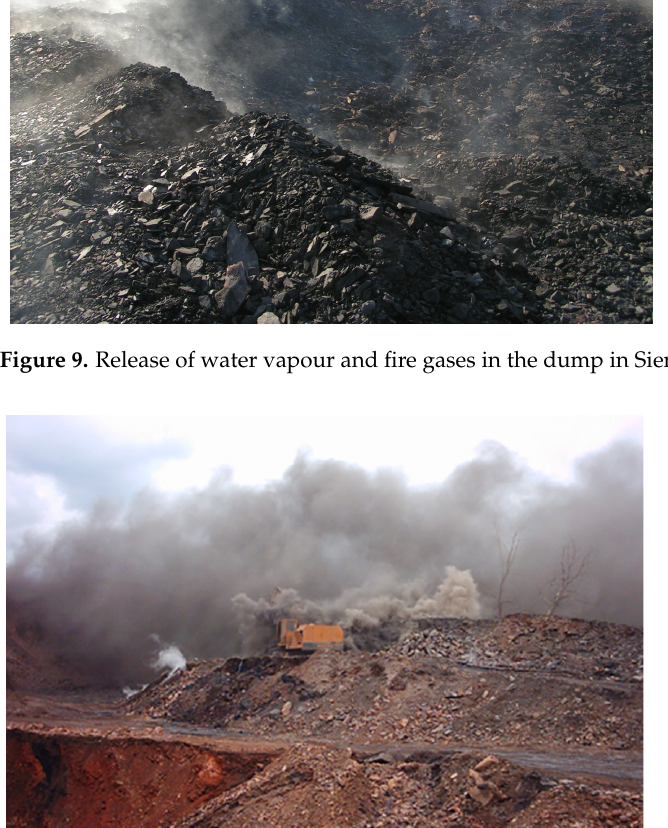
Figure 11. Degradation of the ecosystem from burning dumps in Ruda Ś l ą ska and Bytom.